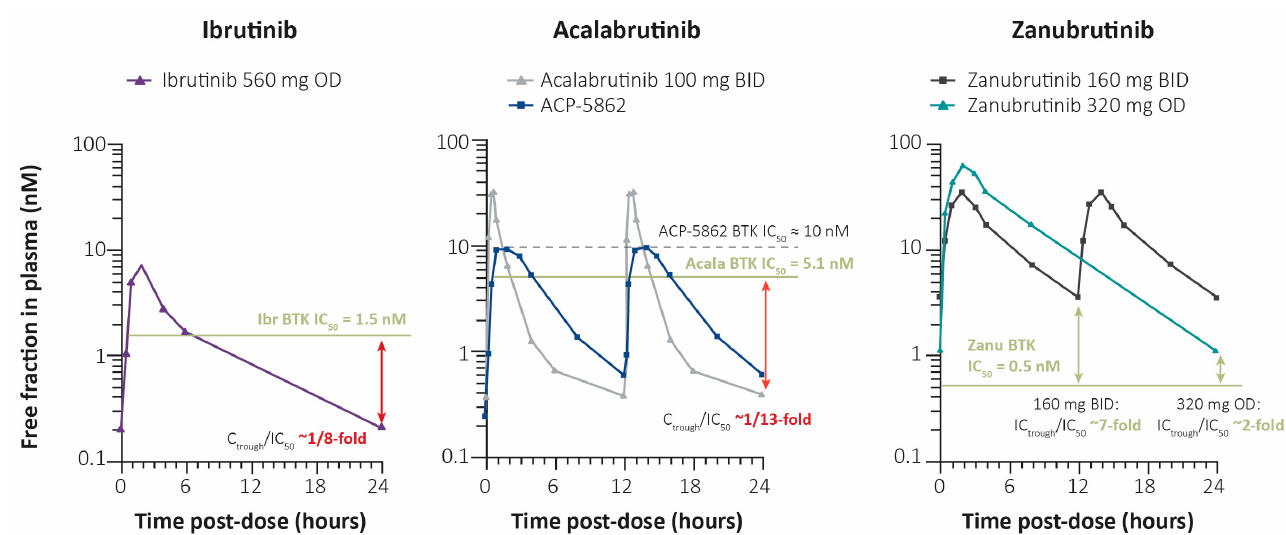
Figure 1. Mean plasma concentration over time for ibrutinib, acalabrutinib, ACP-5862 (major metabolite of acalabrutinib), and zanubrutinib. Adapted with permission from Clinical pharmacology